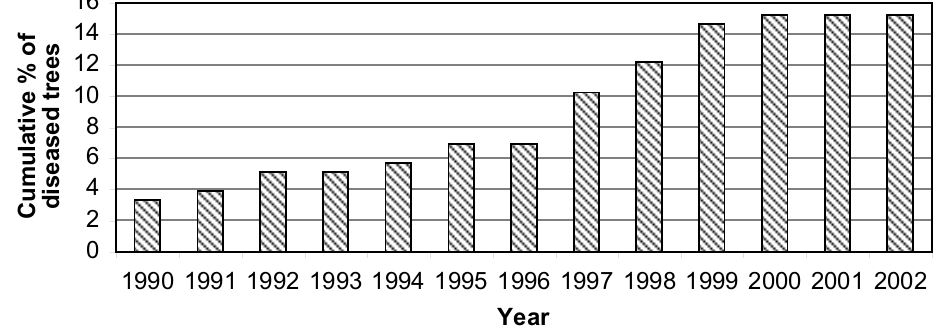
Fig. 3. Cumulative percentages of sharka-infected apricot trees in the orchard studied from 1990 to